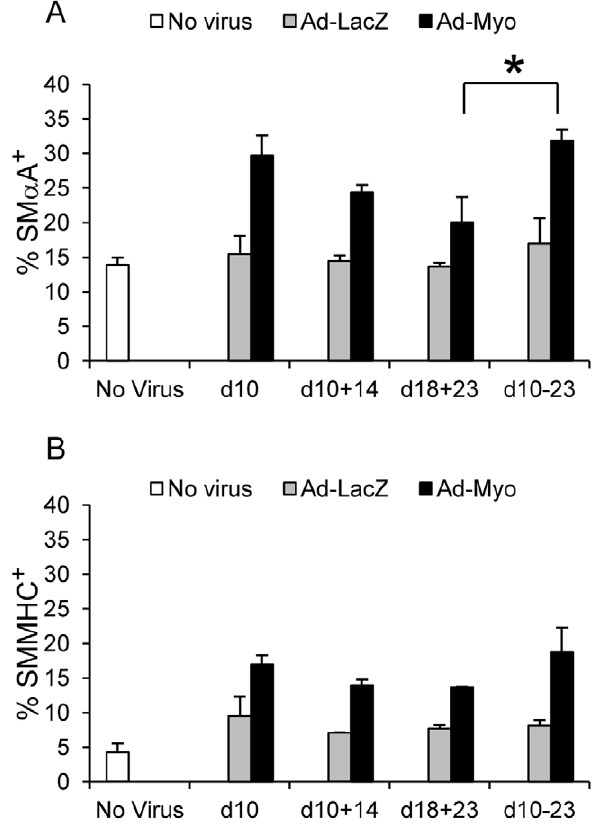
Figure 8. Timing of viral transduction reveals an early role in SMC induction for myocardin. Embryoid bodies were transduced with Ad-LacZ or Ad-Myo early (day 10 alone or days 10 & 14), late (days 18 & 23) or throughout differentiation (days 10, 14, 18 &13). Late delivery of Ad-Myo reduced number of SM a A + cells (A) (*p , 0.05 by ANOVA and Tukey HSD) but had no significant effect on SMMHC + cell numbers (B). Values represent mean cell proportions from three independent experiments ( 6 s.e.m.). *p ,